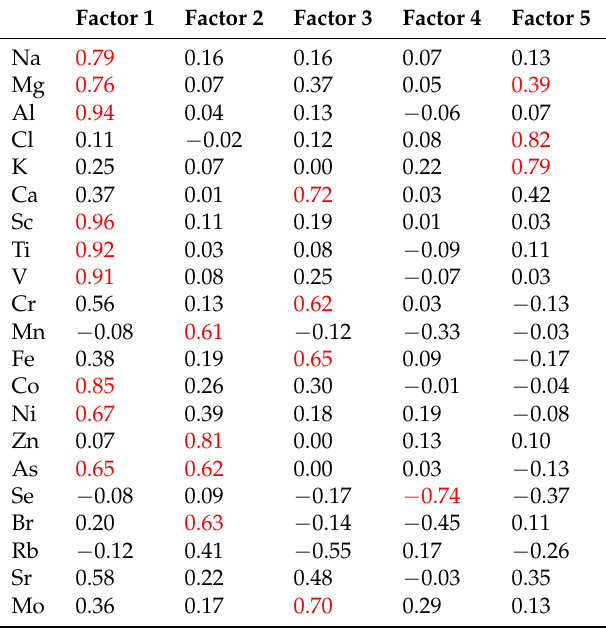
Table 2. Factor loads of individual elements, n =